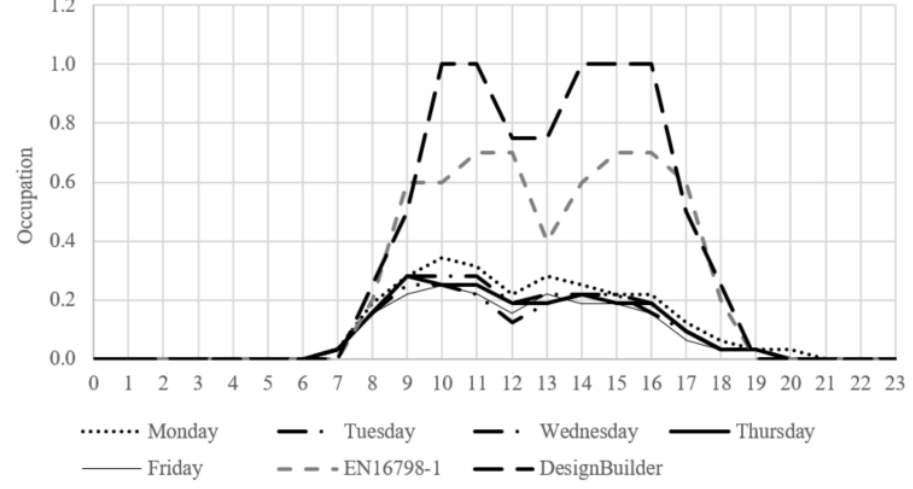
Figure 7. Daily human occupancy schedules.